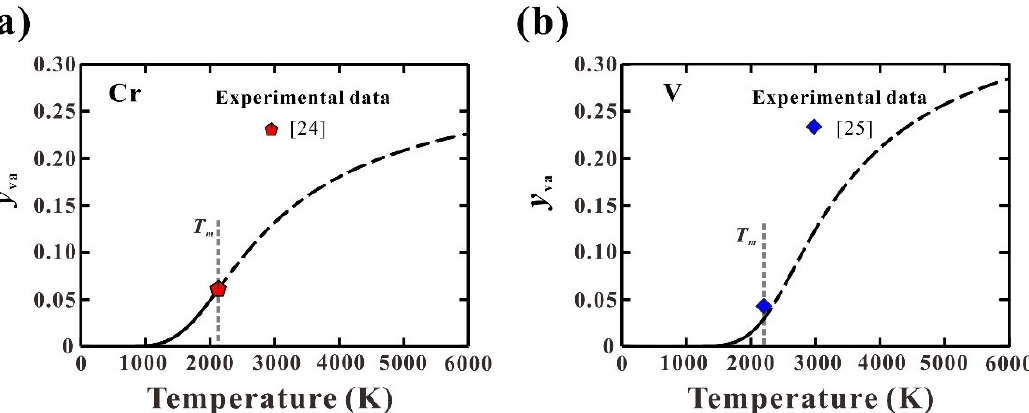
Figure 2. Calculated thermal vacancy concentrations in pure solid ( a ) Cr and ( b ) V along with measured data [24,25] at melting points.